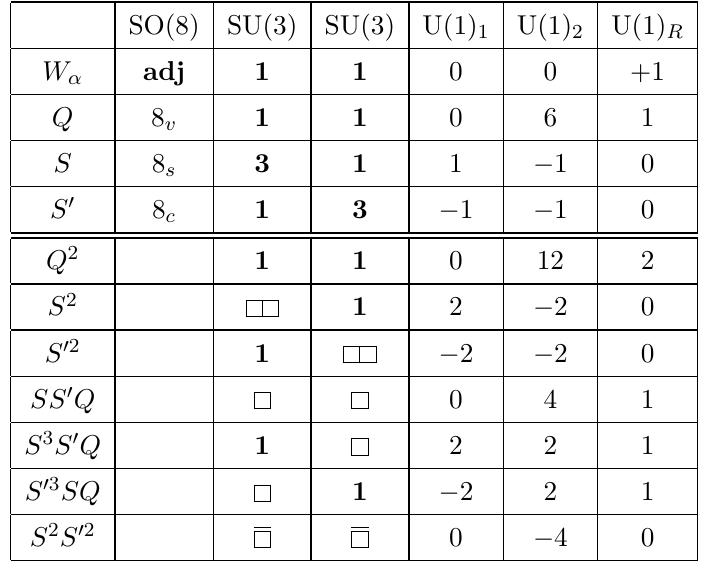
Table 9 . Quantum numbers of fields in the s-confining SO(8) theory and massless composites.